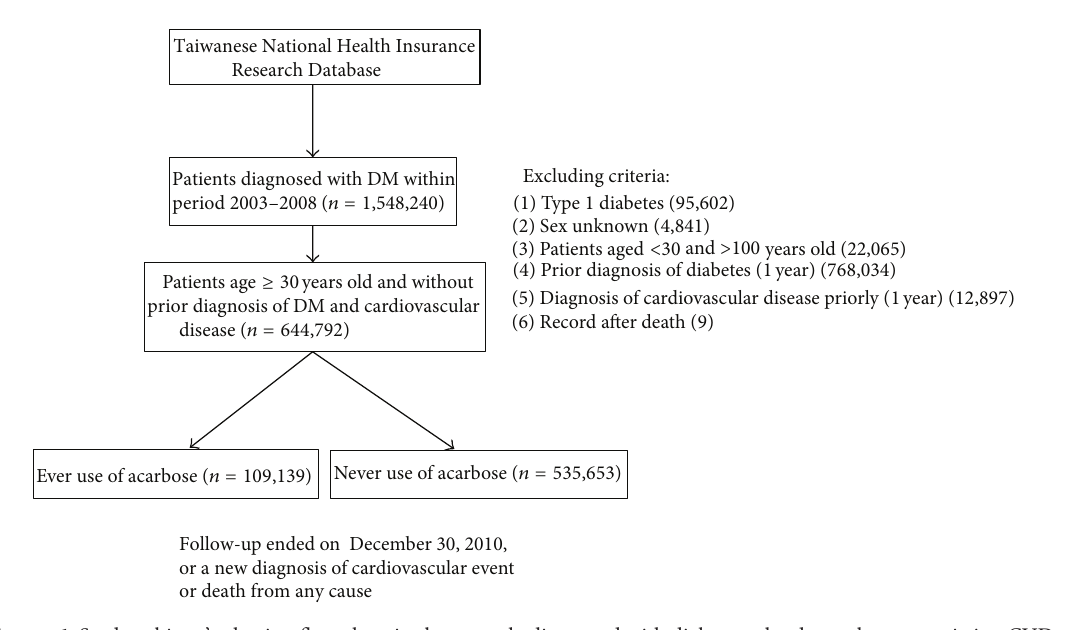
Figure 1: Study subjects’ selection flow chart in those newly diagnosed with diabetes who do not have preexisting